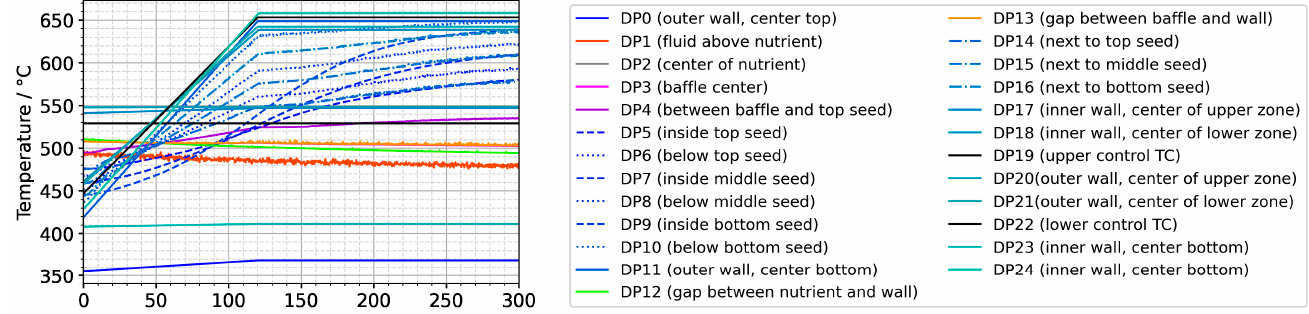
Figure 9. Temperatures over time for the entire set of domain probes.